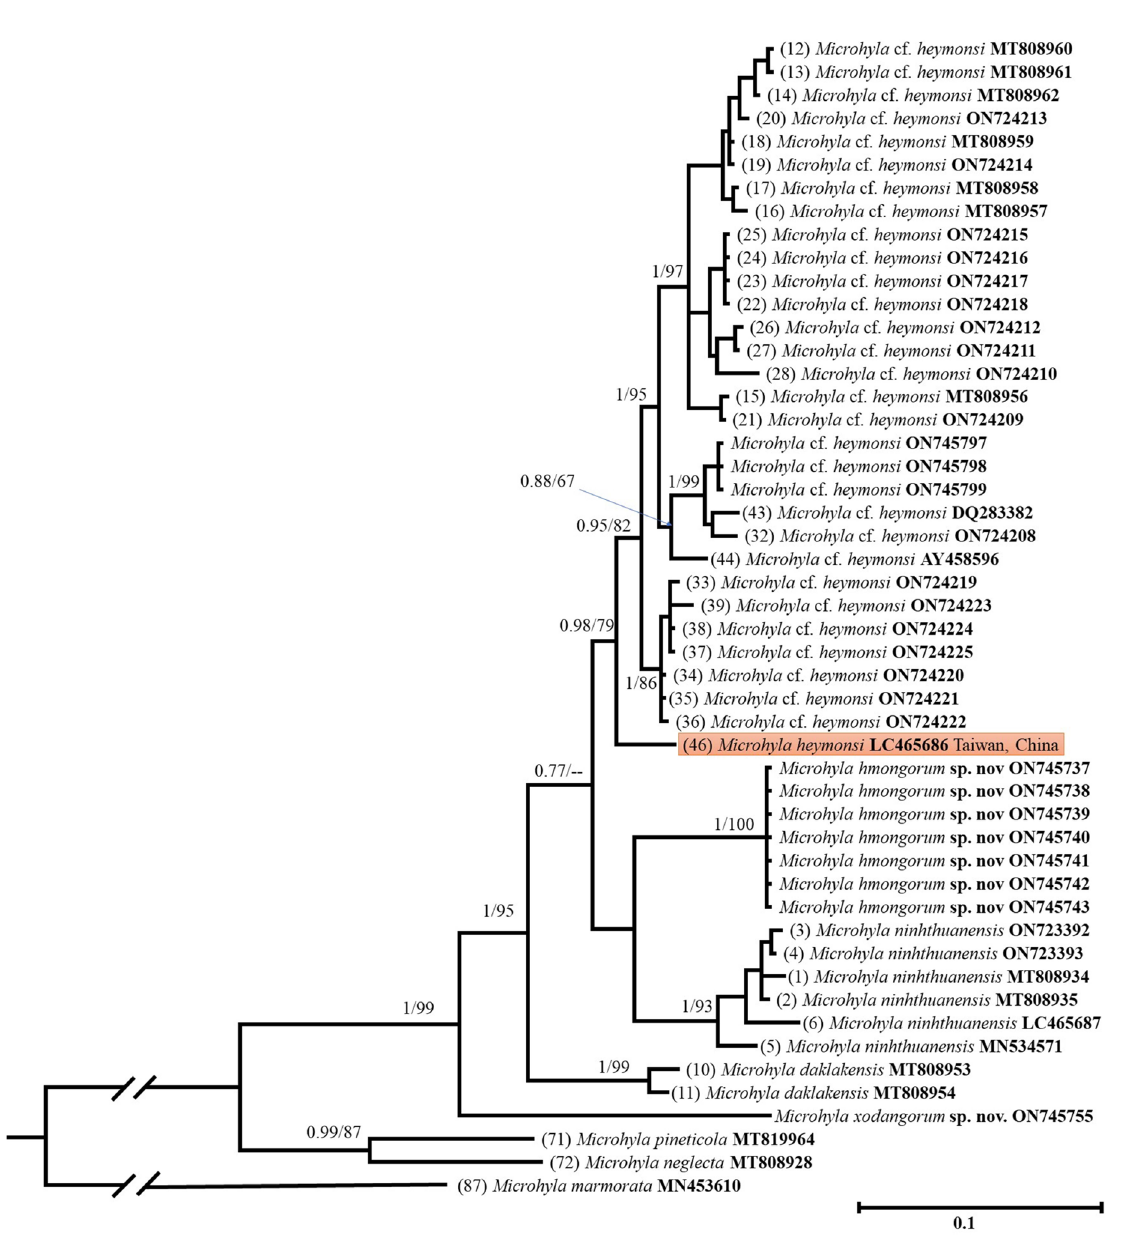
Fig. 2. Bayesian inference matrilineal genealogy of the Microhyla heymonsi group derived from the analysis of 12S rRNA–16S rRNA mtDNA sequences. Numbers above and under branches are Bayesian posterior probabilities and ML bootstrap values. The scale bar represents 0.1 nucleotide substitutions per